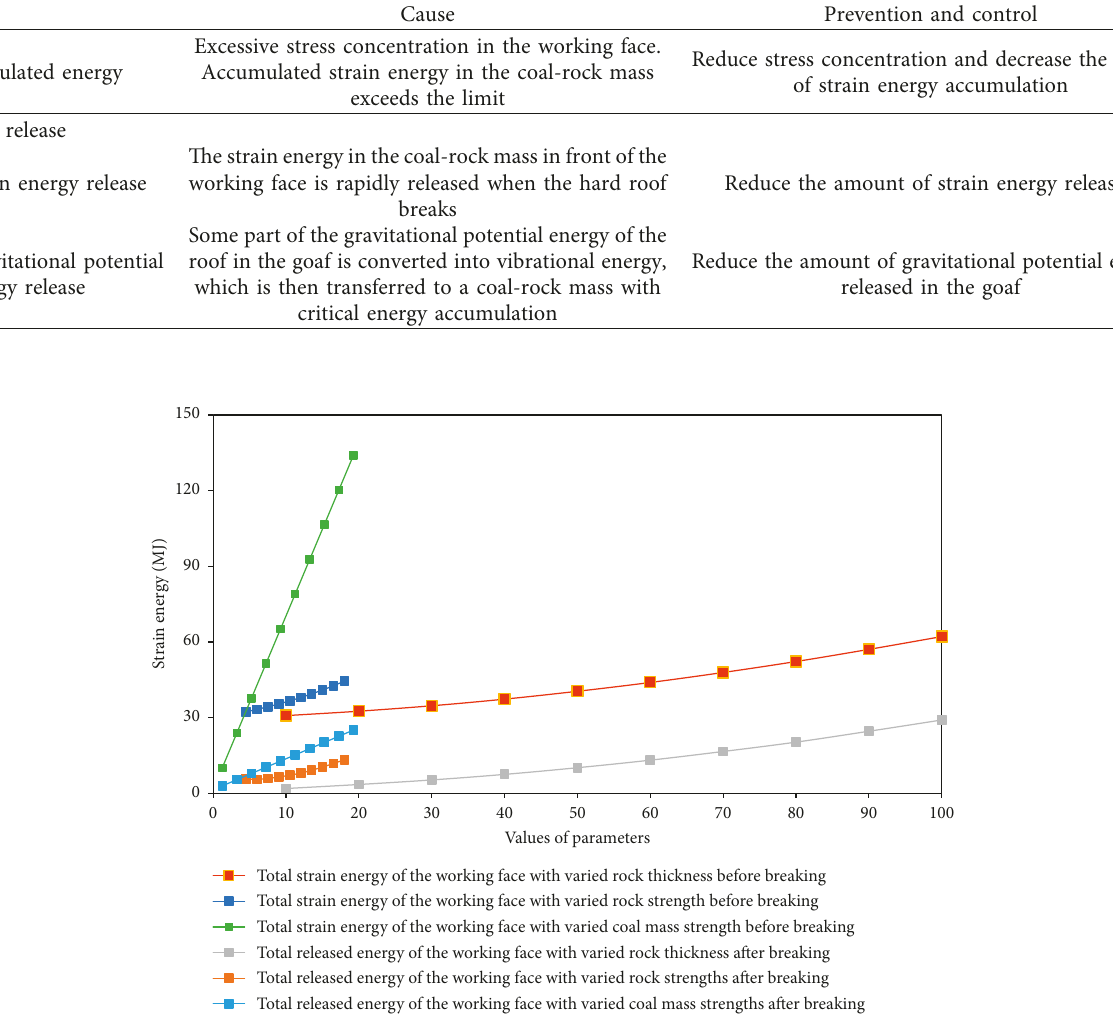
Figure 14: Variation in the total strain energy of the working face before and after the initial roof breakage